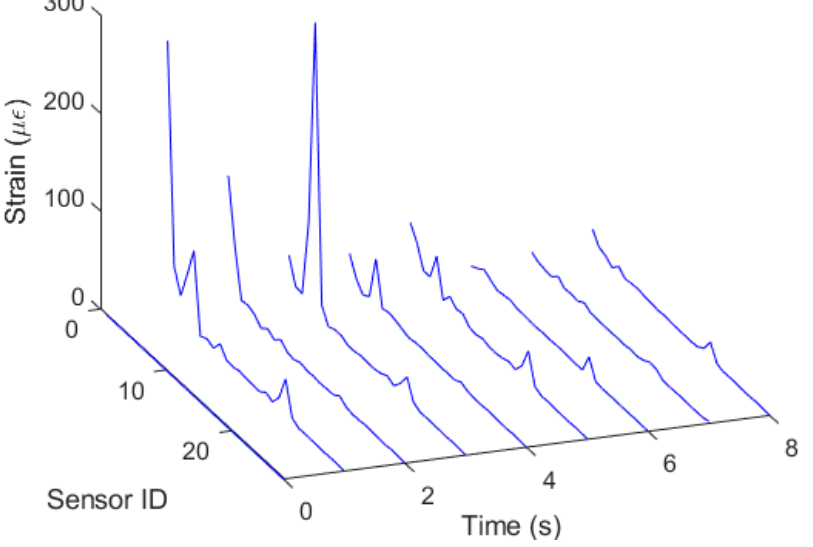
Figure 8. Strain distribution along the optical-fiber-embedded sensor system as a function of time and sensor position.